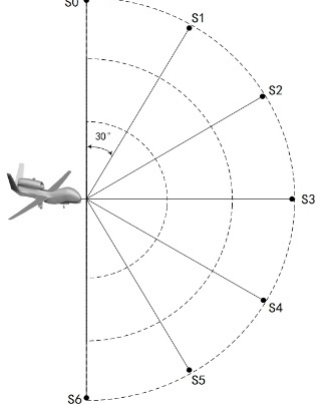
Figure 3. Schematic diagram of status detection code.